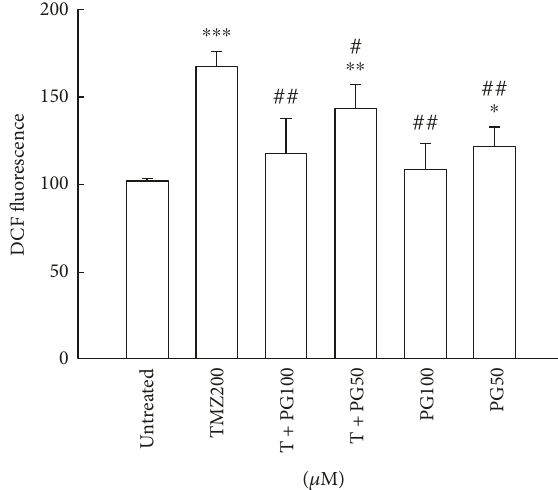
Figure 4: EvaluationofintracellularROSwithTMZ,PG,orTMZ/PG treatment. U87MG cells (1 × 10 6 ) were plated in 60mm cultured dishes for 24h and then treated with TMZ (200 μ M), PG (50 or 100 μ M), or their combination for 48h. After treatment, the cells were stained with 2 ′ ,7 ′ -dichlor fl uorescein-diacetate (DCFDA) for ROS analysis and were then evaluated by fl ow cytometry. Data represent the mean fl uorescence intensity within the cells. The values are presented as mean ± standard deviation ( n = 5 – 8) of individual experiments. Signi fi cant di ff erences for the untreated group and TMZ group were ∗ P < 0 05 , ∗∗ P < 0 01 , ∗∗∗ P < 0 001 , # P < 0 05 , and ## P < 0 01